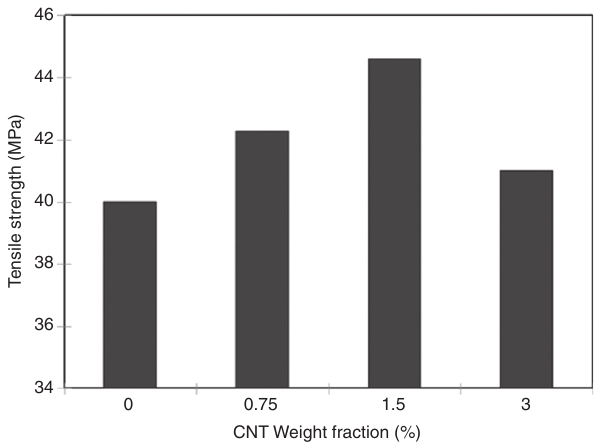
Figure 4 Tensile strength of CNT/epoxy nanocomposites in various CNT weight fractions.